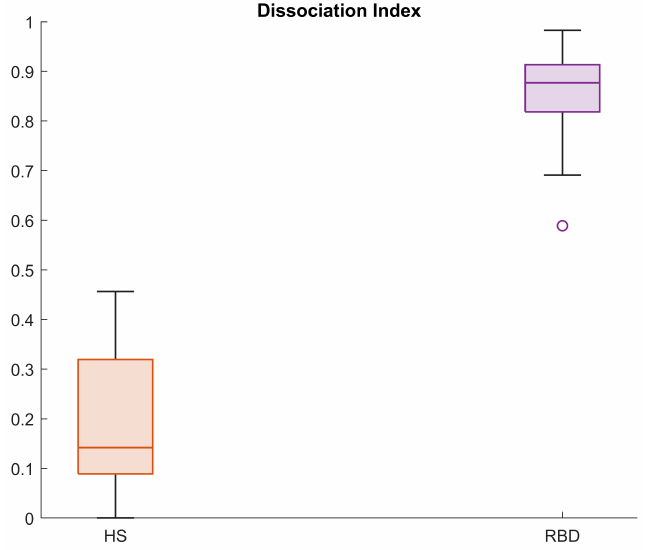
Figure 12. Boxplots for the Dissociation Index computed in the HS and RBD groups (CAP Sleep